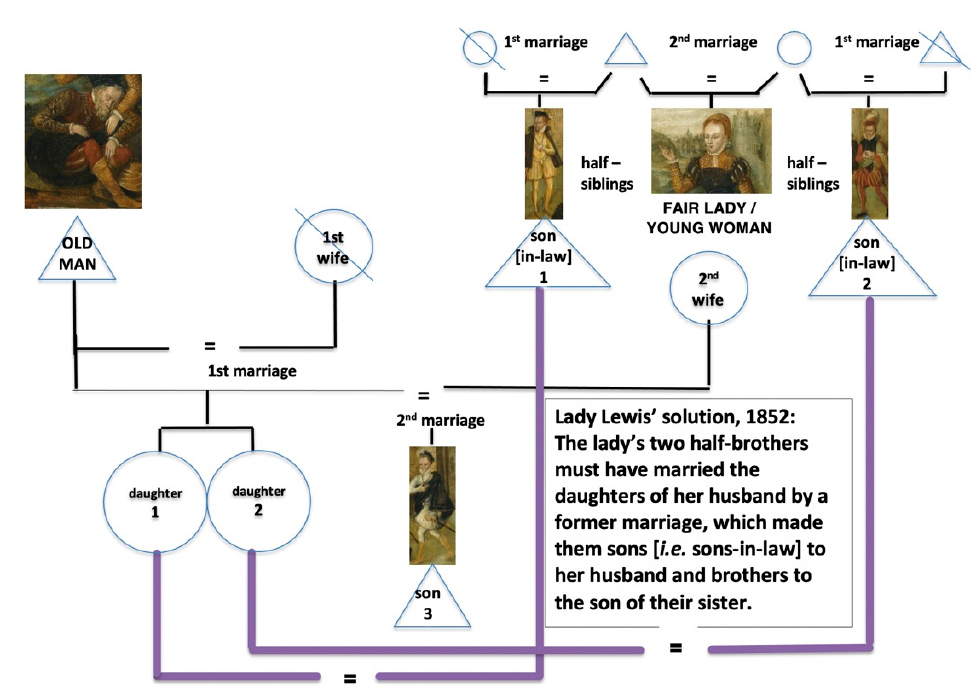
Figure 11. A drawing of the solution as presented in the text of Lady Theresa Lewis, Lives of the Friends and Contemporaries of Lord Chancellor Clarendon , III, 286, no. 12. London. Shown with the fig- ures from ‘A Riddle devoted to … Sir William Cecil’, c. 1565–70, sold from the estate of the 7th Earl of Clarendon and now at Hatfield House, UK. Drawing credit: Lyndan